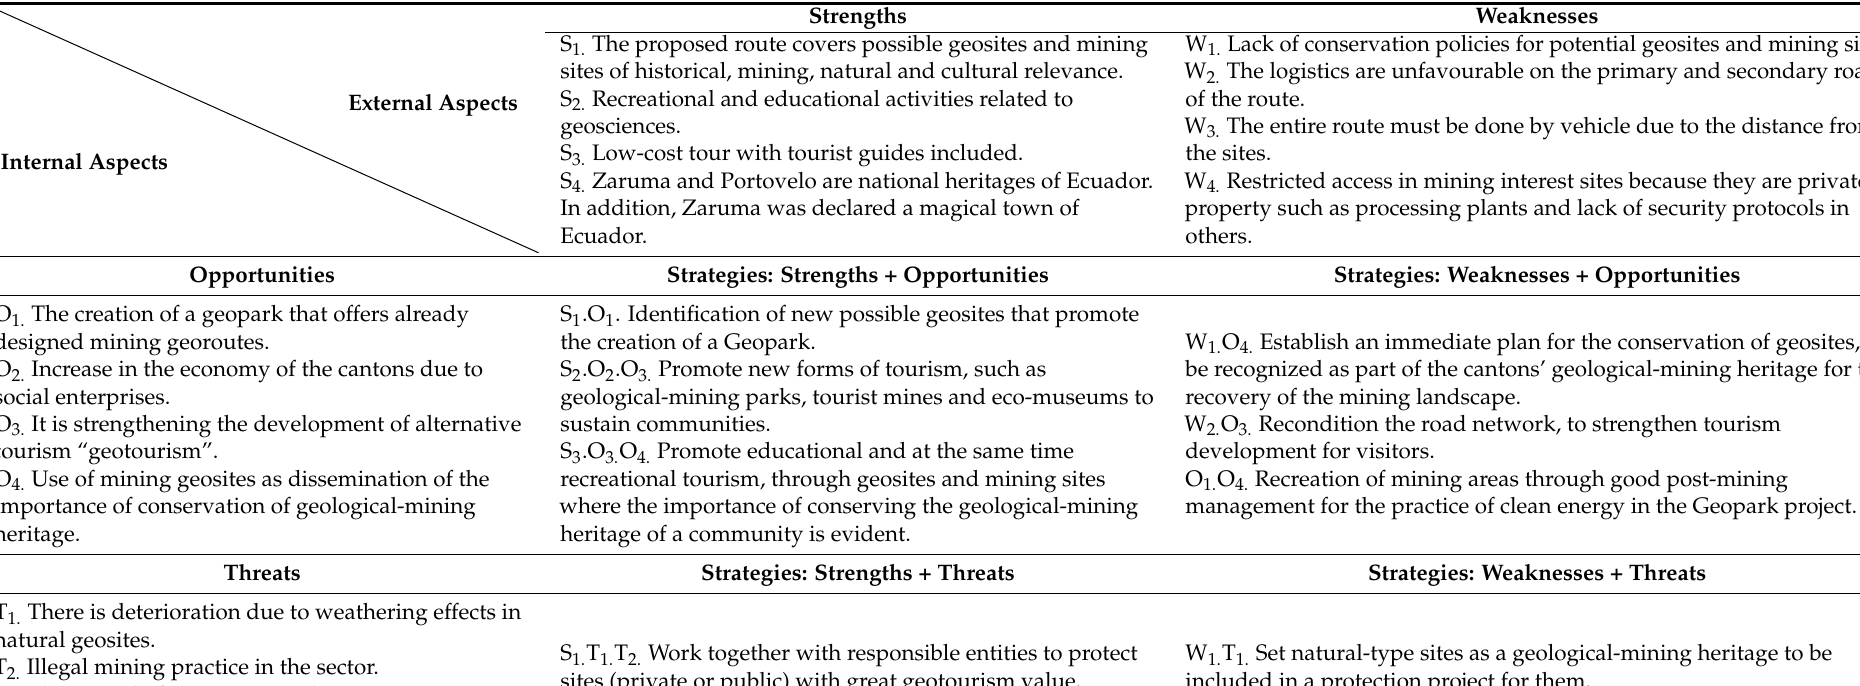
Table 4. Analysis and SWOT matrix of the routes studied and